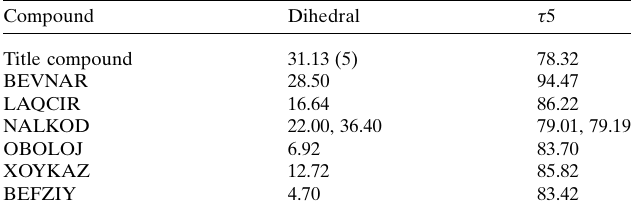
Table 2 Selected dihedral and torsion angles ( (cid:2) ).